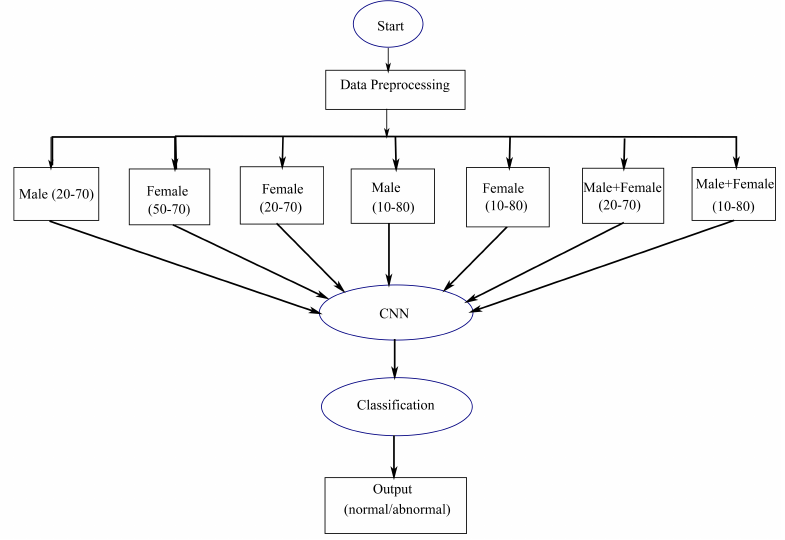
Figure 1. An overall flowchart, depicting proposed classification approach by using age and gender as